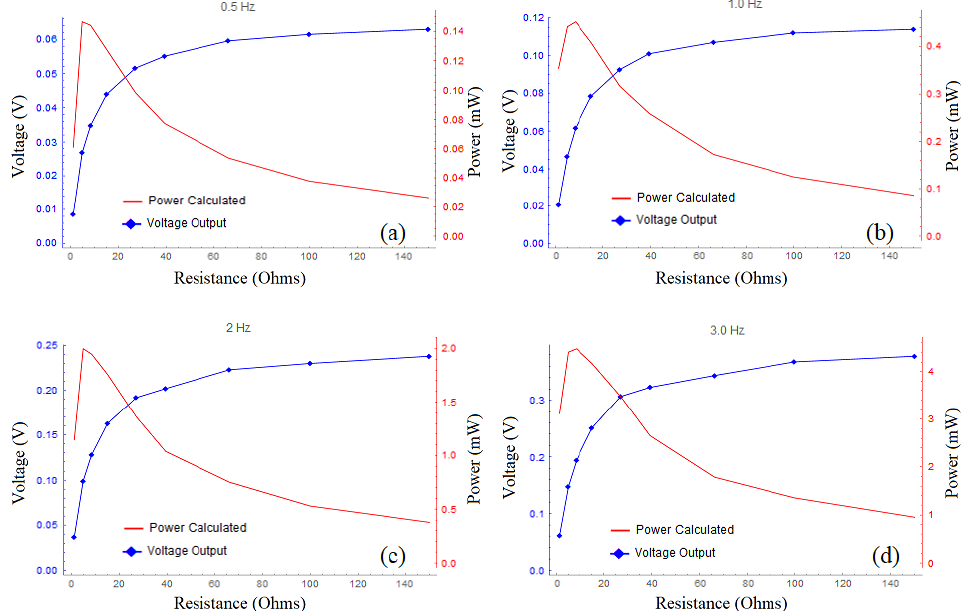
Figure 13. Voltage and power outputs for the crank-slider harvester at 0.5, 1.0, 2.0, and 3.0 Hz. The devices depicted in each figure ( a – d ) had a 50 mm stroke length with the coil located at the center of oscillation. The coil had an internal resistance of 8.1 Ω